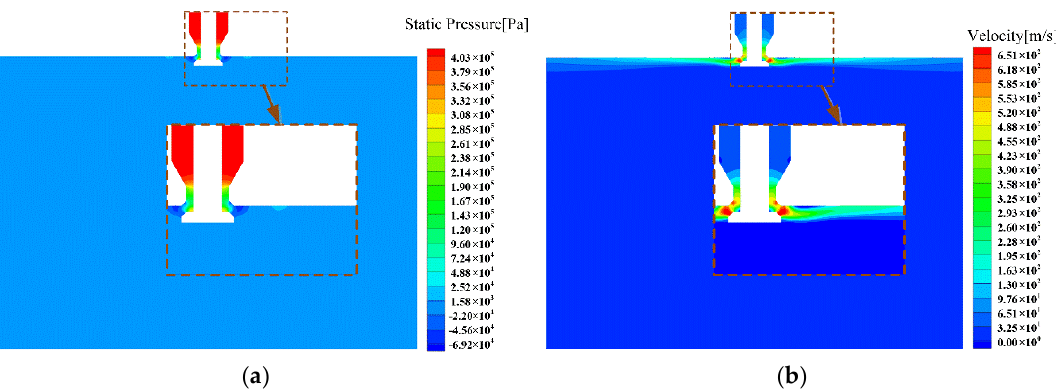
Figure 8. The outflow pressure and velocity contour of the type A push-open injector. ( a ) Static pressure contour; ( b ) Velocity contour (inlet pressure, 4 bar).